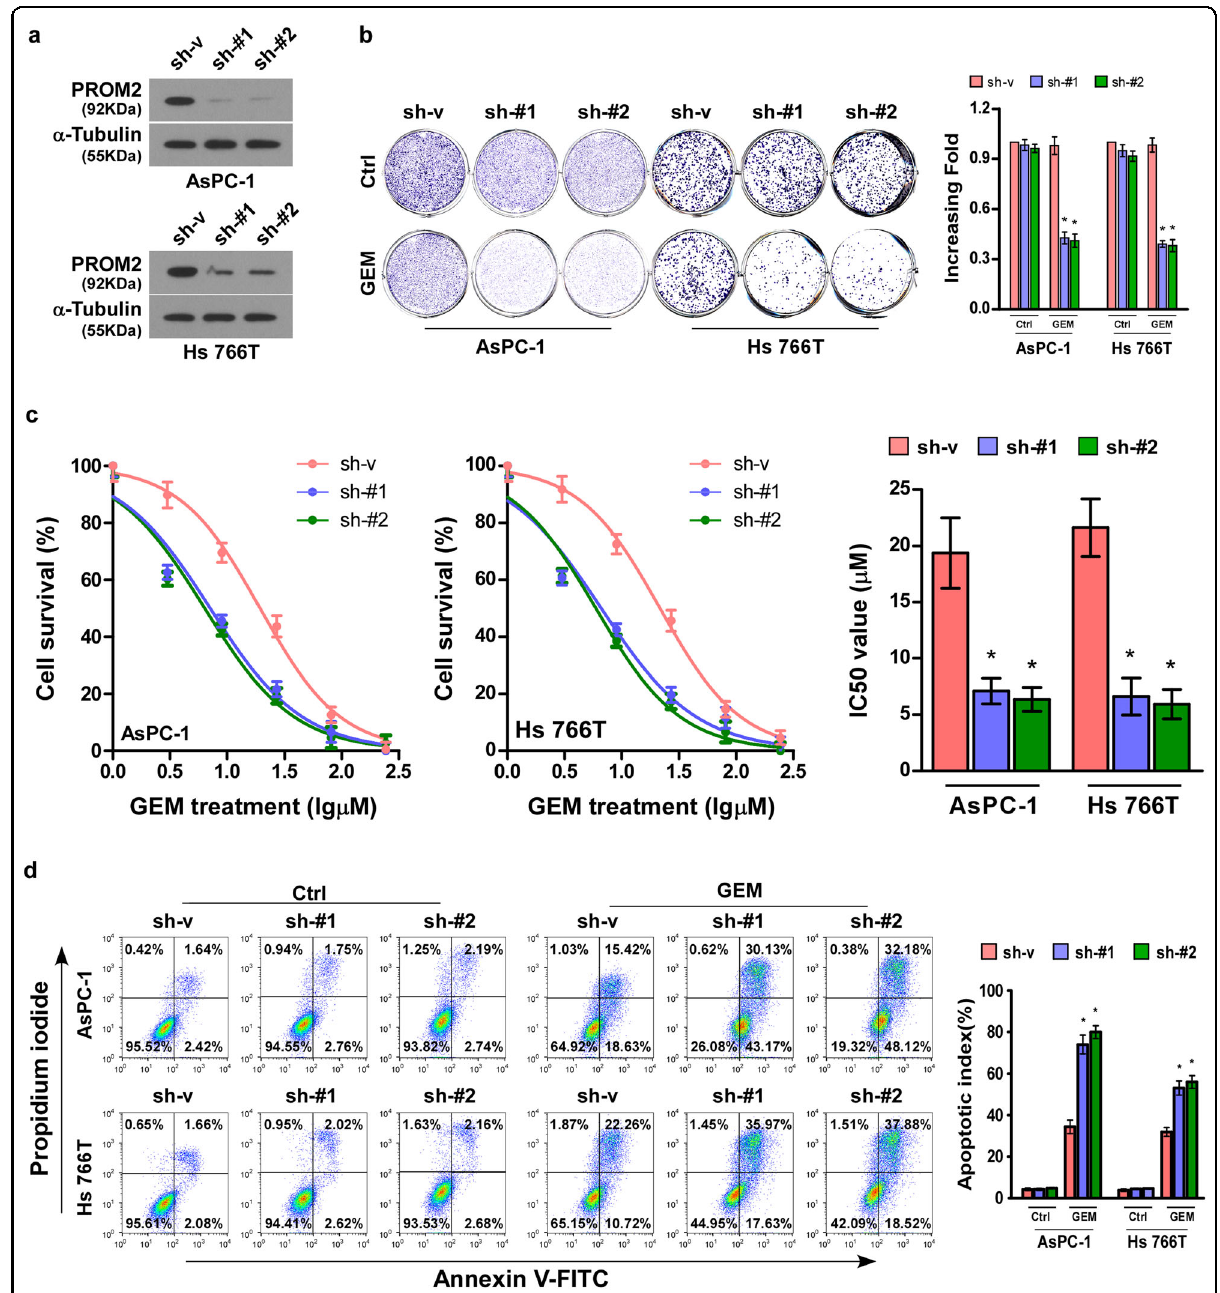
Fig. 3 Silencing of PROM2 induces gemcitabine chemosensitivity in pancreatic cancer cells. a Western blot of PROM2 protein expression in indicated cells. b Representative images (left) and quanti fi cation data (right) of colony numbers in the indicated cells treated with vehicle or gemcitabine (10 μ M) (mean± SD, n = 3; * P < 0.05). c MTT cell viability assay and IC 50 value of gemcitabine (10 μ M) in the indicated cells (mean ± SD, n = 3; * P < 0.05). d FACS analysis of Annexin-V and PI staining (left) and quanti fi cation (right) of indicated cells treated with Gemcitabine (10 μ M) (mean± SD, n = 3; * P <